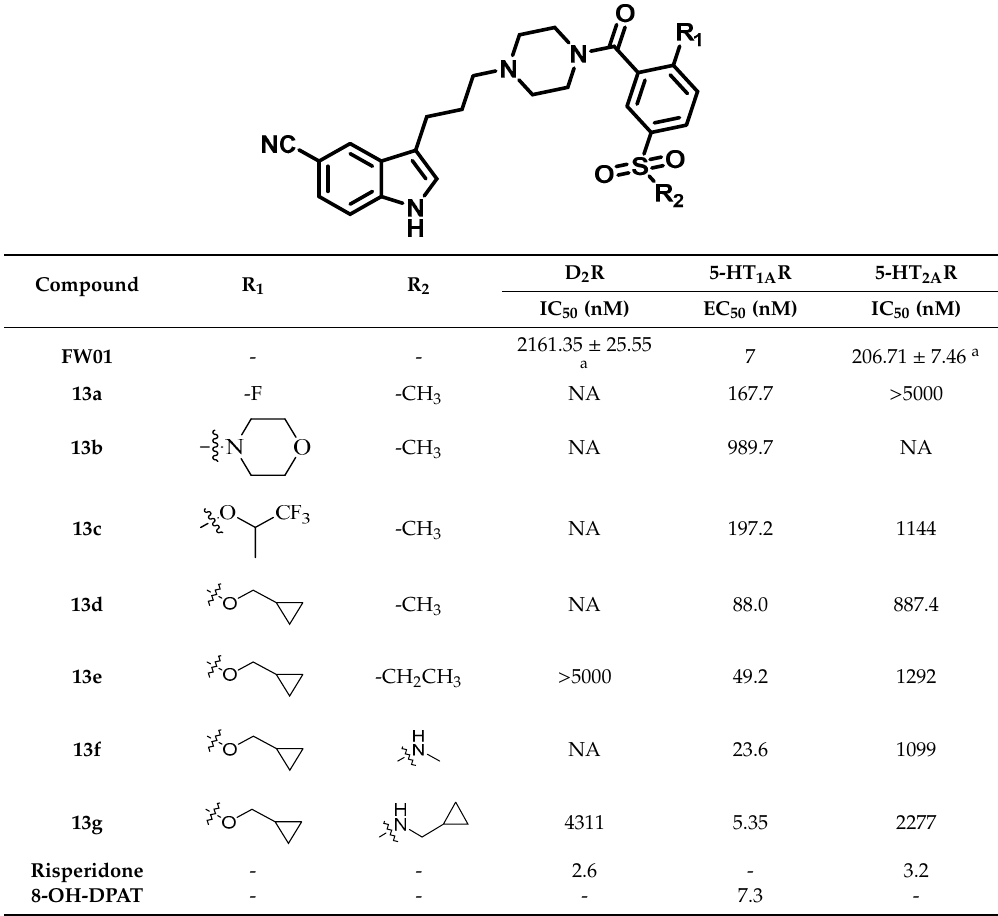
Table 1. Functional activities of compounds 13a – 13g for dopamine receptor (D 2 R) and serotonin receptors (5-HT 1A R and 5-HT 2A R).